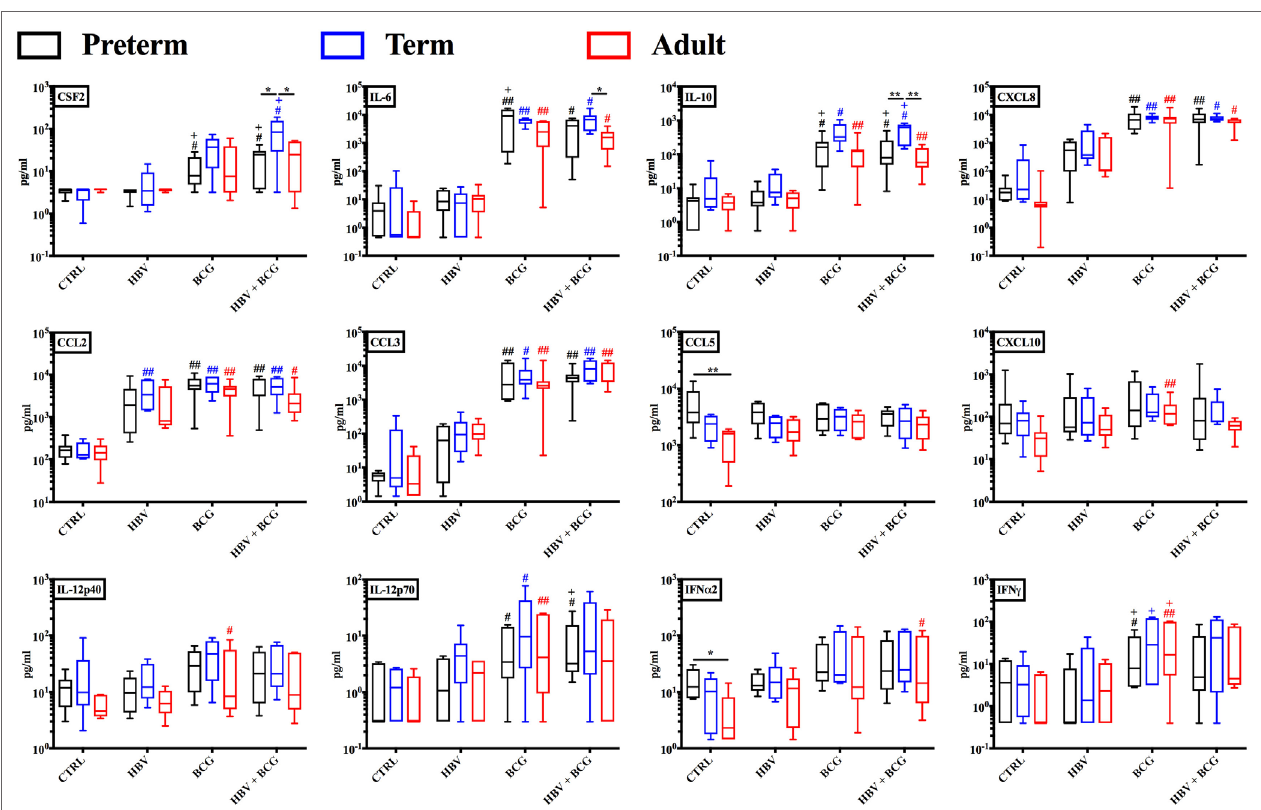
FigUre 2 | Cytokine and chemokine profiles induced by hepatitis B vaccine (HBV) and Bacille Calmette–Guérin (BCG) in human preterm, term, and adult whole blood. Preterm, term, and adult whole blood was stimulated for 6 h with either HBV, BCG, or (BCG + HBV) and supernatants analyzed via Multiplex Cytokine Analysis. Statistical significance was determined by repeated measure or ordinary one-way ANOVA with Holm-Sidak post hoc test (or their non-parametric equivalent Friedman or Kruskal–Wallis with Dunn post hoc test). * p < 0.05, ** p < 0.01 of preterm vs. term vs. adult; #, + p < 0.05, ##, ++ p < 0.01 of groups indicated by the corresponding color, respectively, vs. saline or HBV. N = 7 preterm newborns, N = 6 term newborns, N = 7